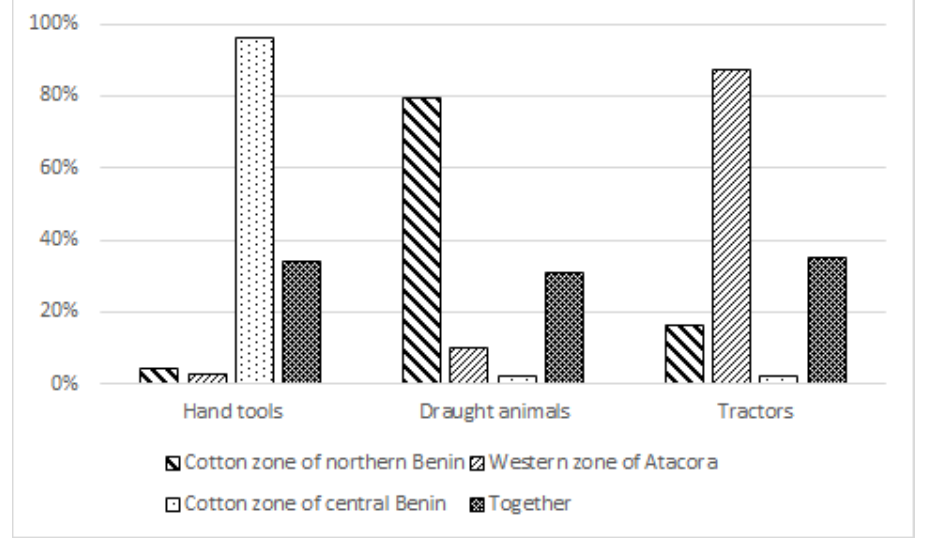
Figure 1. Mechanization status in cotton production.